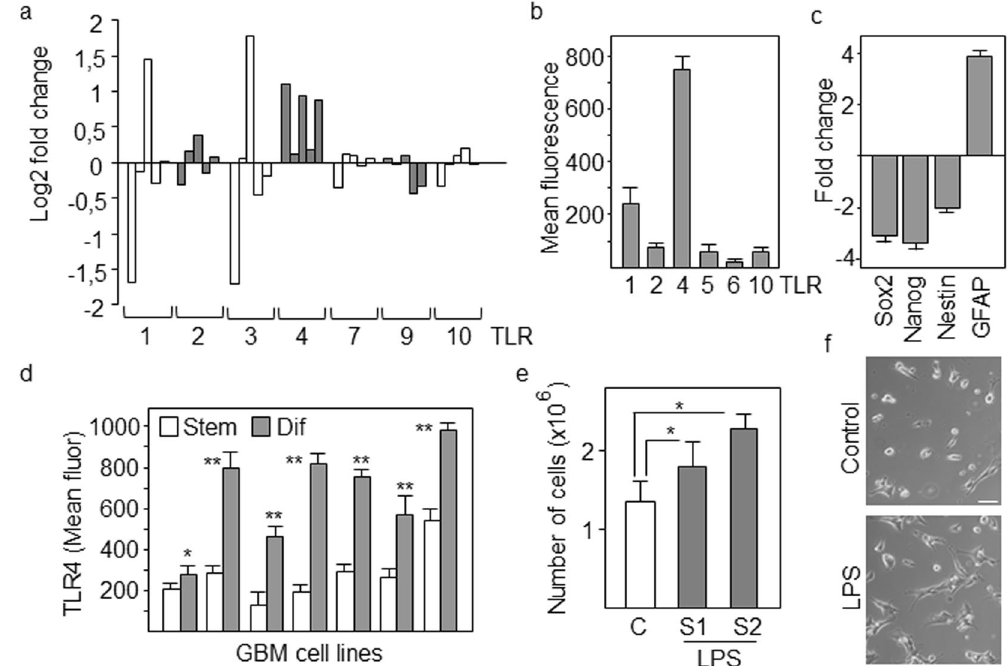
Figure 1. TLR4 is upregulated in differentiating GSCs. (a) Fold changes in the levels of TLR genes in differentiating compared with stem-like cells as assessed by gene expression microarray. (b) Flow cytometry analyses of TLRs. The expression in differentiating cells relative to stem-like cells is represented. ( c ) GSCs were induced to differentiate in the presence of serum for 4 days. The expression of progenitor (Nestin, Sox2, Nanog) and lineage (GFAP) markers was analyzed by qPCR. The expression levels were represented as fold changes of differentiating cells compared with GSCs. All markers showed significant differences (p < 0.01). ( d ) Expression levels of TLR4 protein in different GBM cell lines as determined by flow cytometry. Asterisks represent significant differences ( * p < 0.05, ** p < 0.01) compared to stem-like cells. (e) Proliferation and (f ) Morphology of GSCs after 4 days of differentiation in the presence of LPS from E. coli strains O111:B4 (S1) and O55:B5 (S2). * p < 0.05. Histograms represent the mean ± SD of three independent experiments. Scale bar: 50 μ